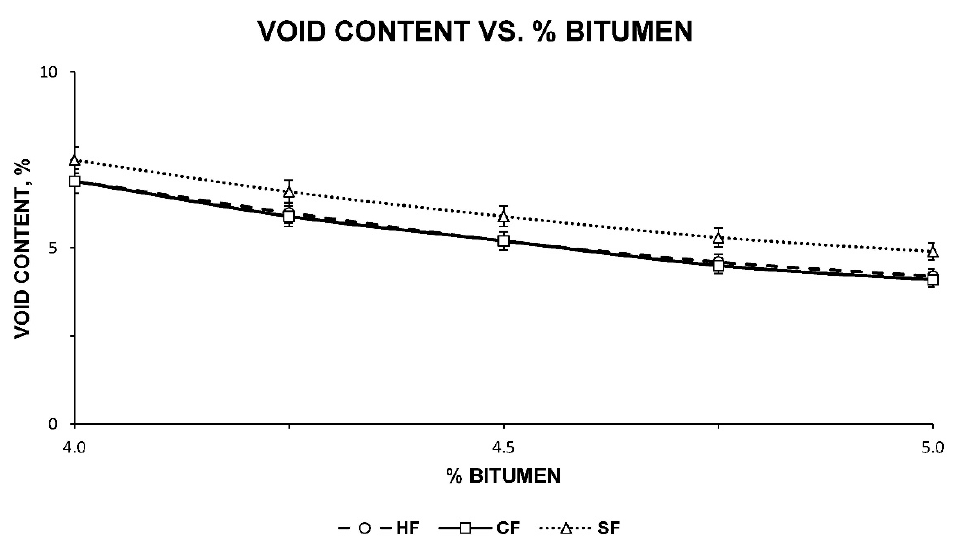
Figure 7. Void content of the HF, CF and SF families of bituminous mixtures as a percentage of bitumen.